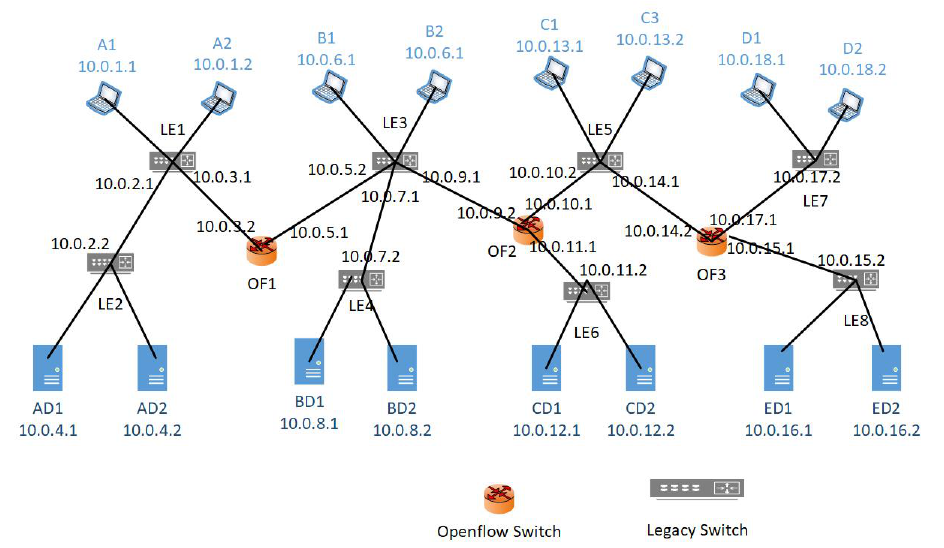
Figure 5. An example Scenario containing SDN and Legacy switches connected with end Nodes.